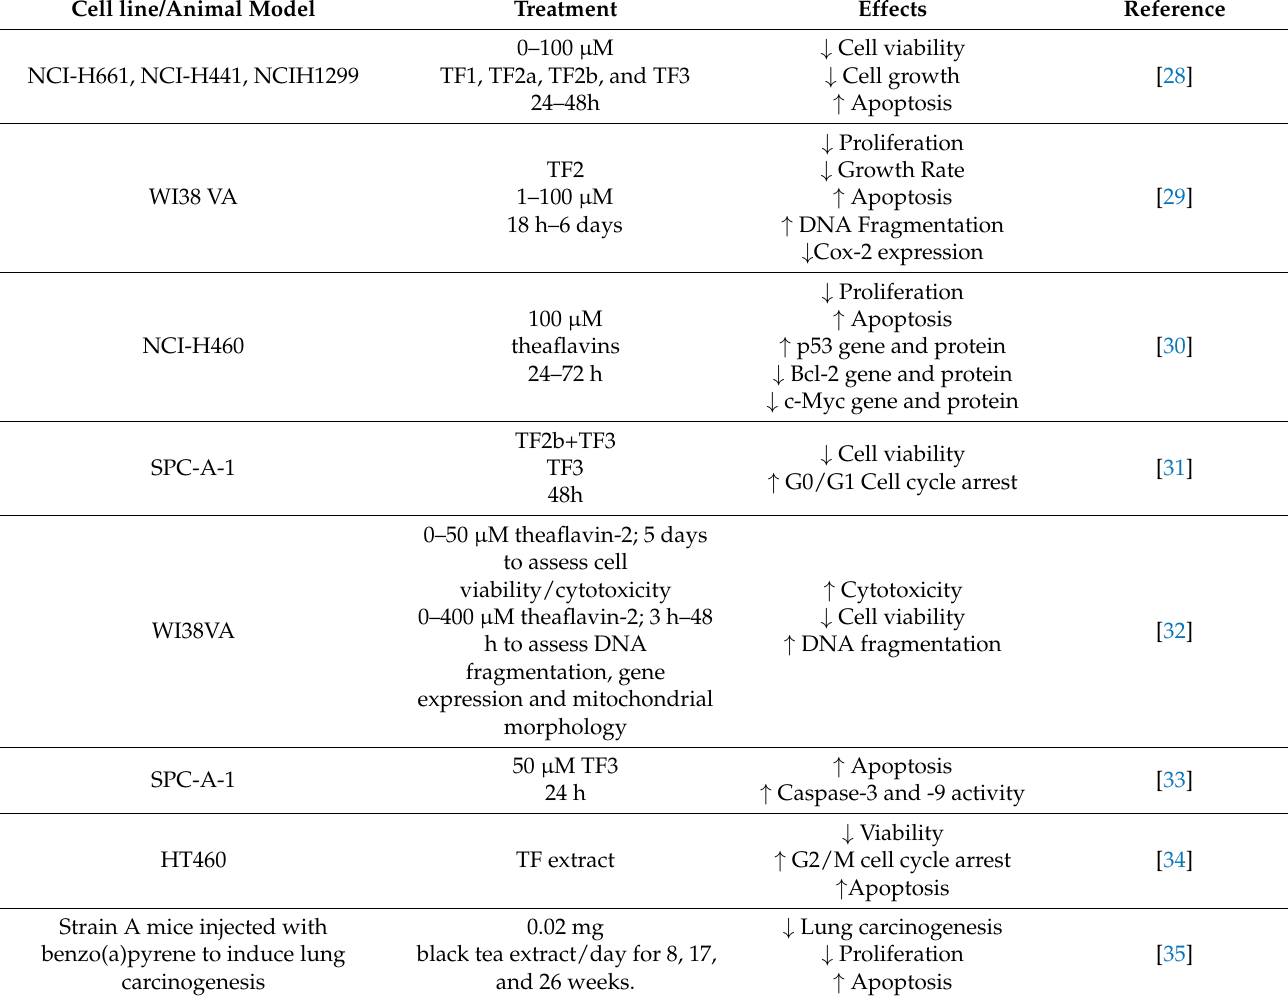
Table 3. Effects of theaflavins in lung